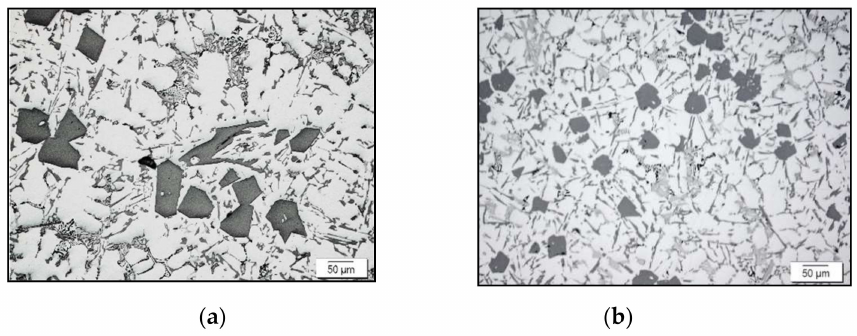
Figure 7. Microstructure of hypereutectic alloy 5: ( a ) untreated; ( b ) complex